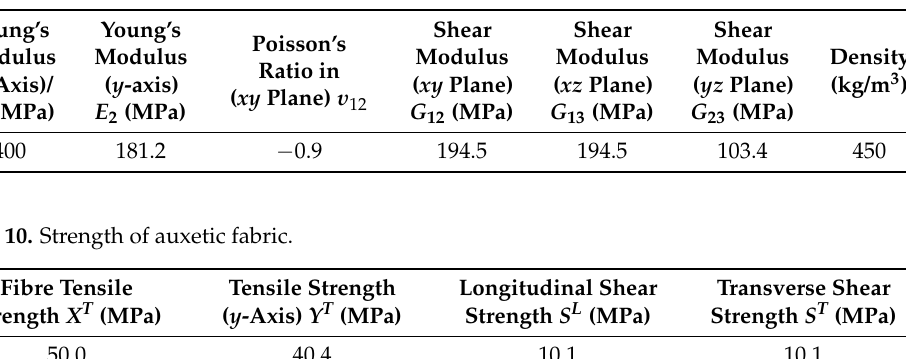
Table 9. Elastic properties of auxetic fabric.